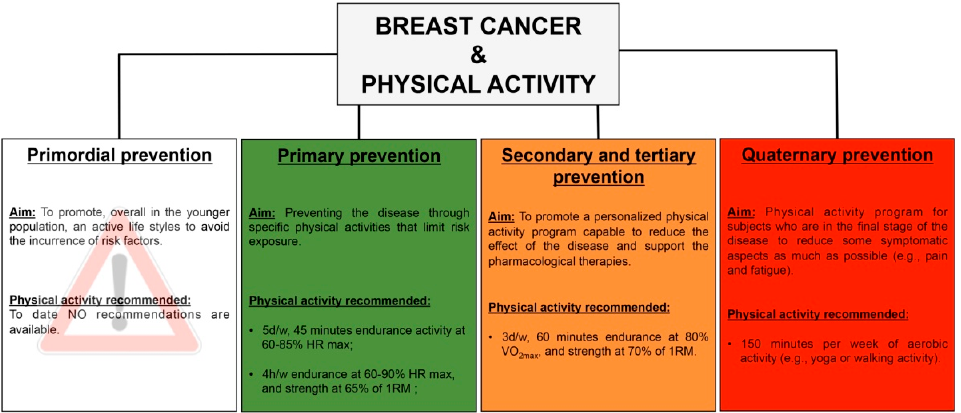
Figure 3. Physical activity recommendations based on scientific evidence and stratified for each pre- vention level of breast cancer. d, day; w, week; HR max, heart rate max; 1RM, one-repetition maxi- prevention level of breast cancer. d, day; w, week; HR max, heart rate max; 1RM , one-repetition mum .